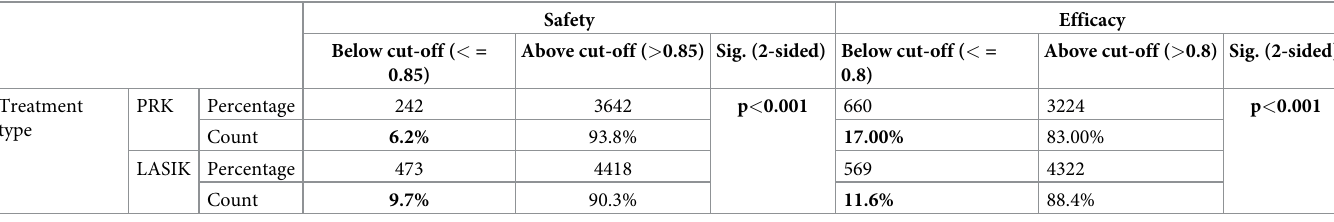
SEQ = spherical equivalent; LASIK = laser assisted in situ keratomileusis P-value indicates association between treatment type and outcome above/below cut-off.